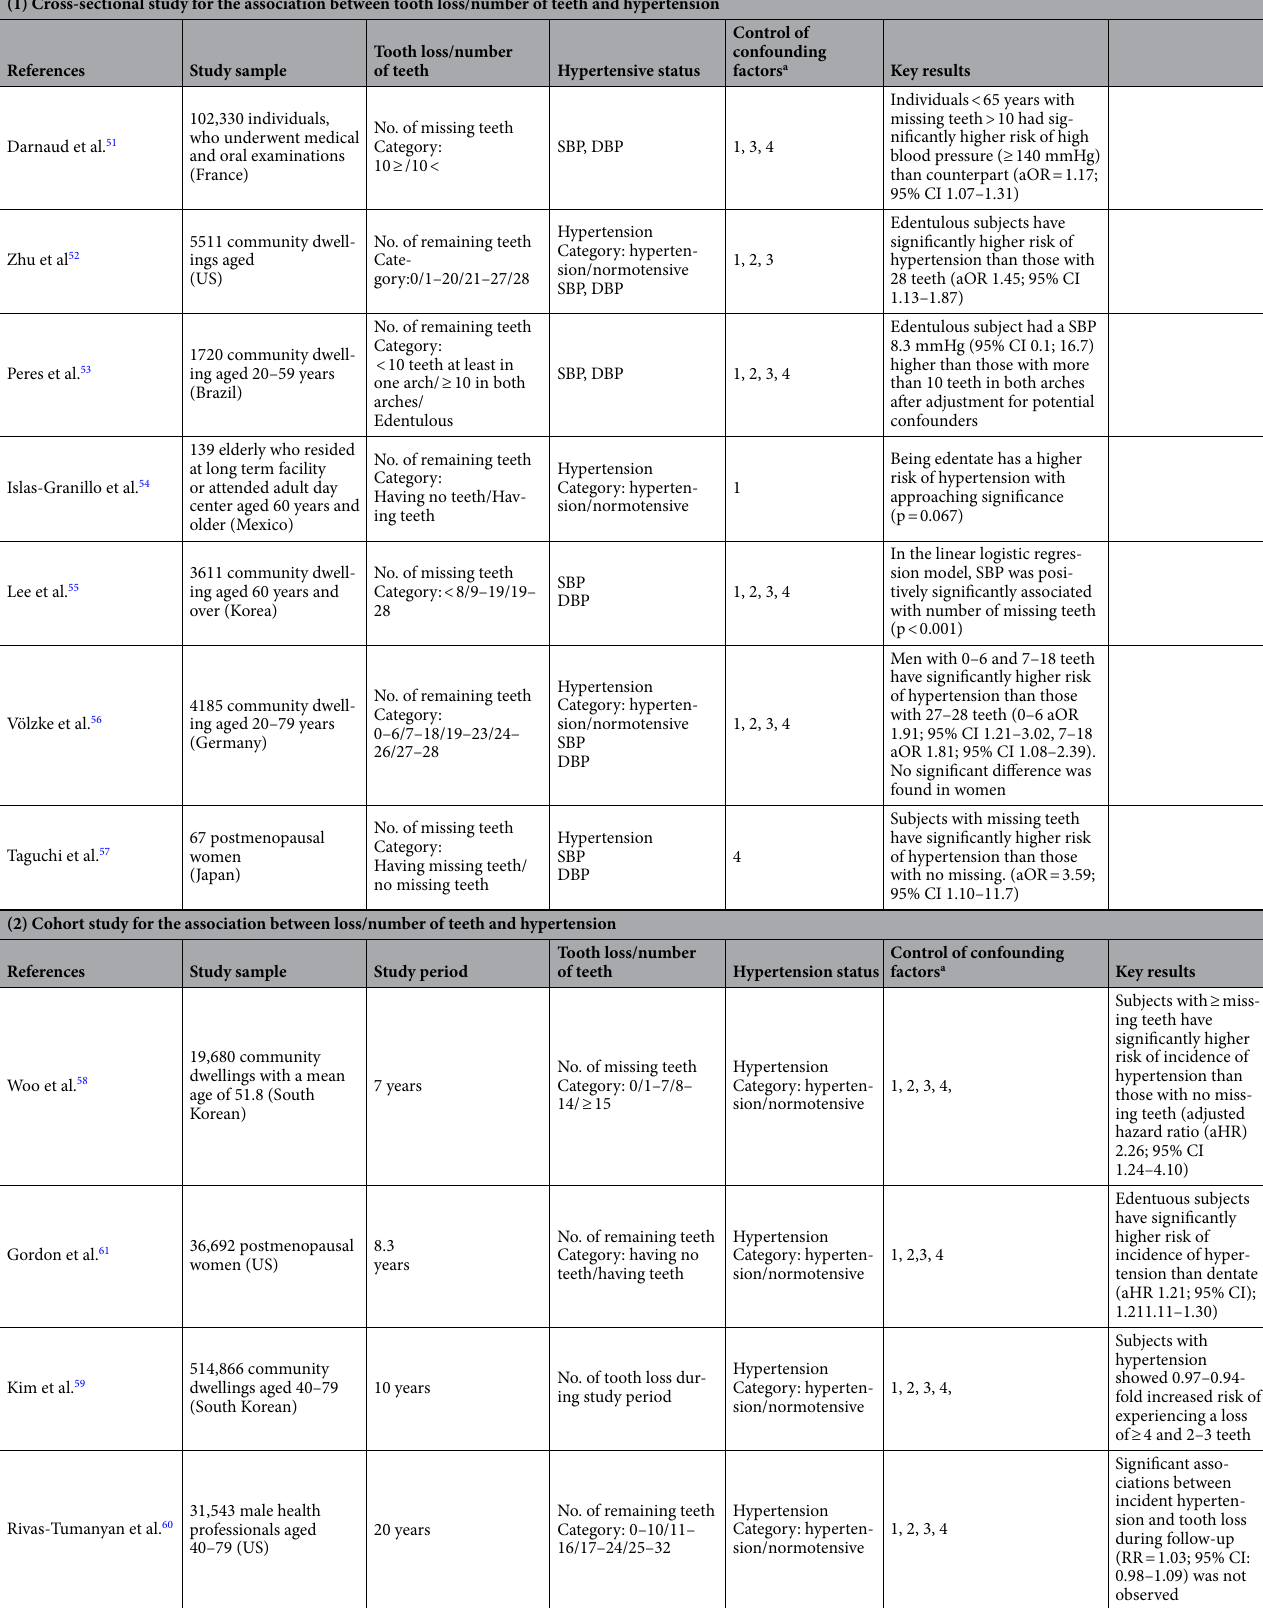
Table 1. Summary of studies on the relationship between tooth loss/number of teeth and hypertension. a The following variables were controlled for in the analyses or with separate results: 1, demographic factors; 2, socio- economic factors; 3, smoking/alcohol; 4, diabetes, hypercholesterolemia, and